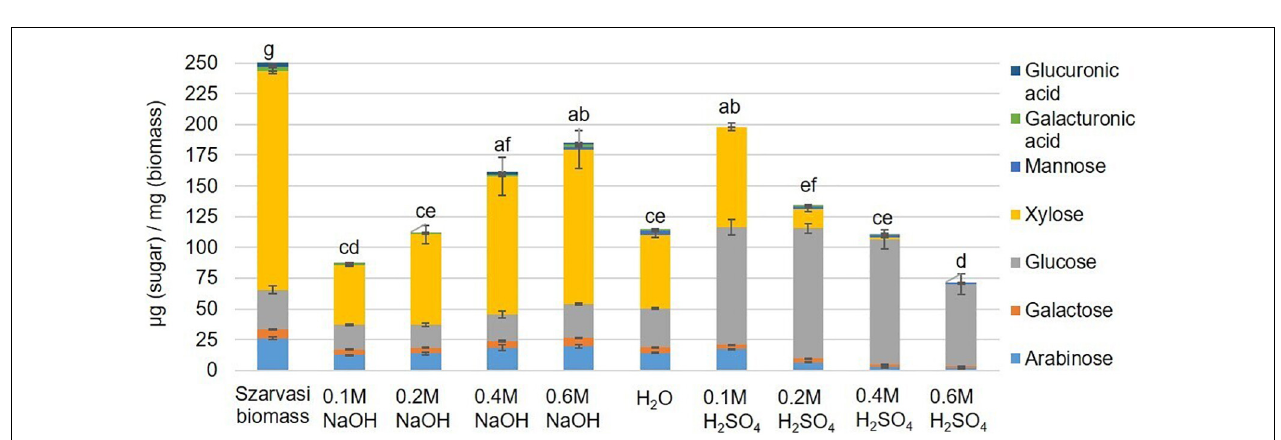
FIGURE 5 | Monosaccharide composition ( µ g sugar/mg biomass) in Szarvasi hydrolysates of different microwave pretreatments. Different letters above bars indicate significant differences, assigned based on the ANOVA Tukey HSD test ( n = 3).